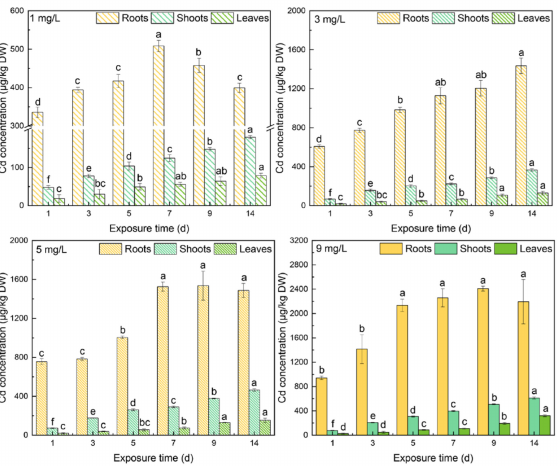
Figure 4. The Cd concentrations in different tissues under different levels of Cd stress. All values represent the means ± SD of three replicates. Significant differences ( p < 0.05) at different time points in the same tissue are indicated with different